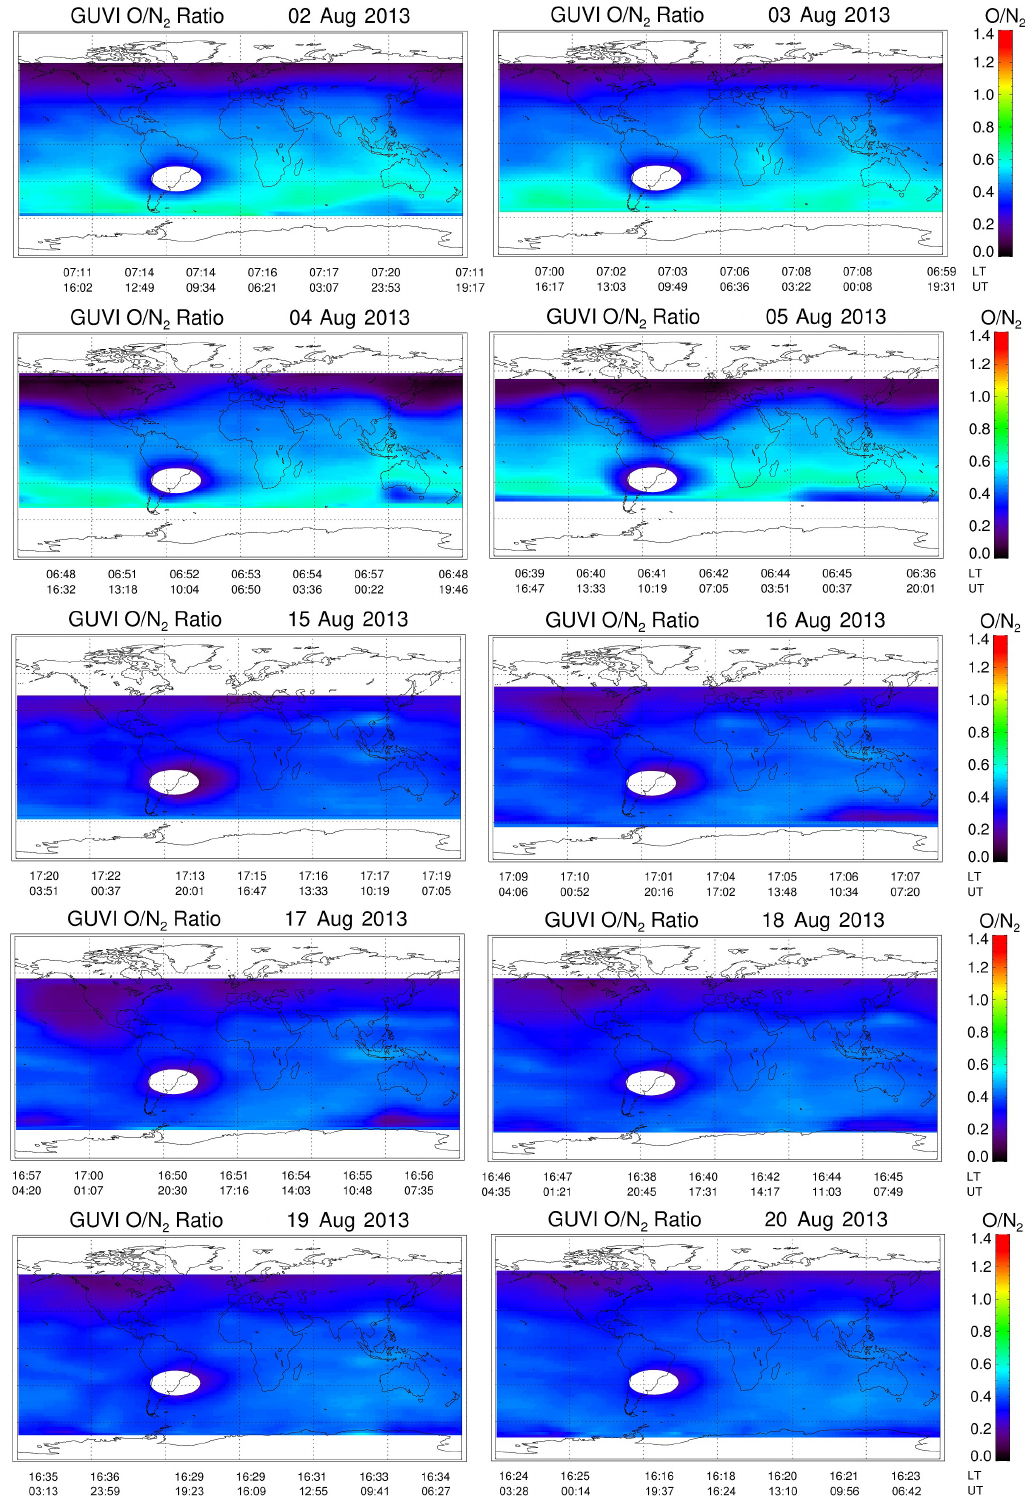
Figure 10. O / N 2 ratios measured by the GUVI instrument onboard the TIMED satellite, for the period 2–5 and 15–20 August